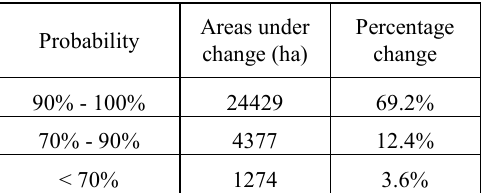
Table 5. Probable rate of future change during